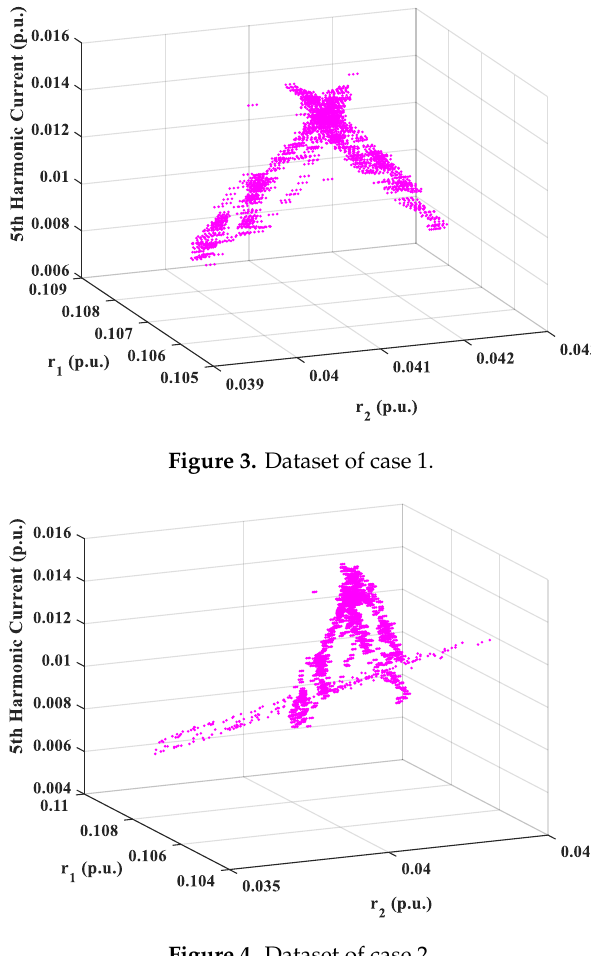
Figure 4. Dataset of case 2.